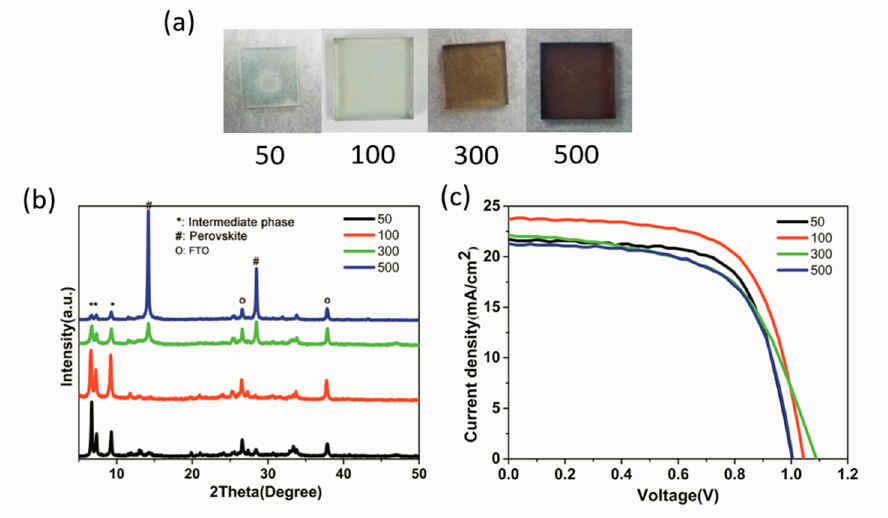
Figure 11. ( a ) The intermediate film photo by different quantity of EA (50 µL, 100 µL, 300 µL, 500 µL); ( b ) XRD spectra of intermediate films; ( c ) J-V curves of devices. Table 2. Photovoltaic parameters of device by using different quantity of anti-solvent EA.